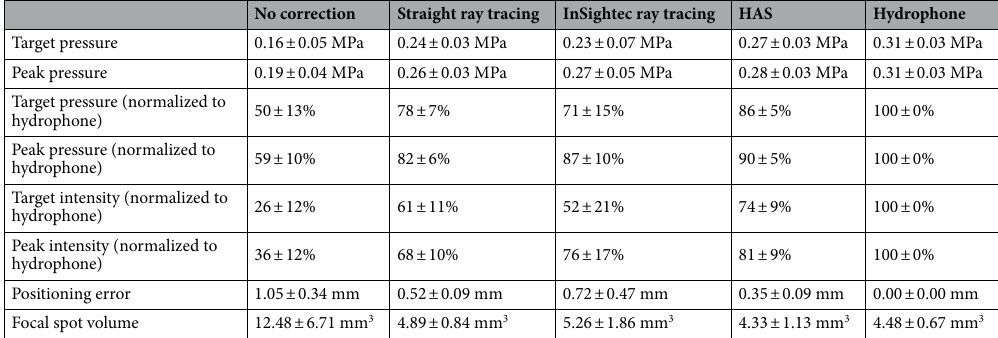
No correction Straight ray tracing InSightec ray tracing